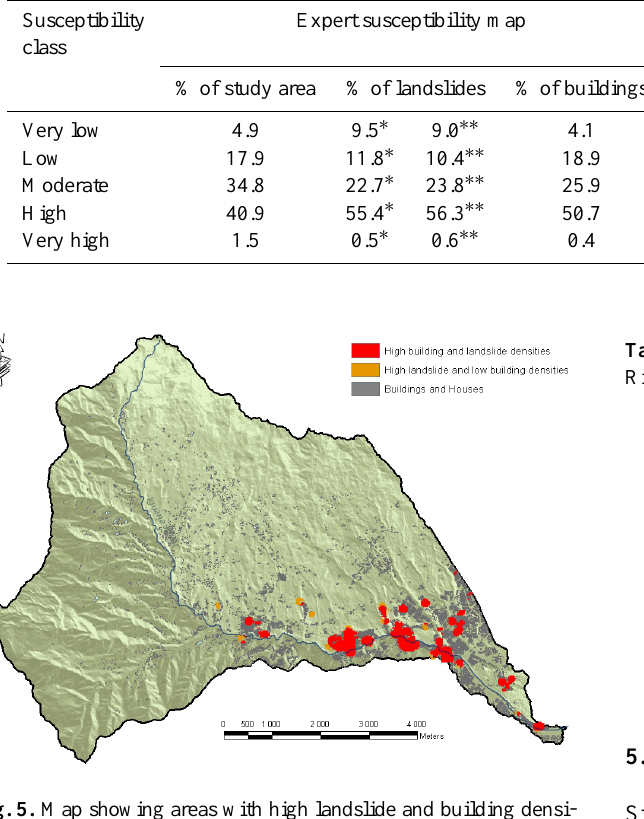
Fig. 5. Map showing areas with high landslide and building densi- ties (red), and high landslide and low building densities (orange).